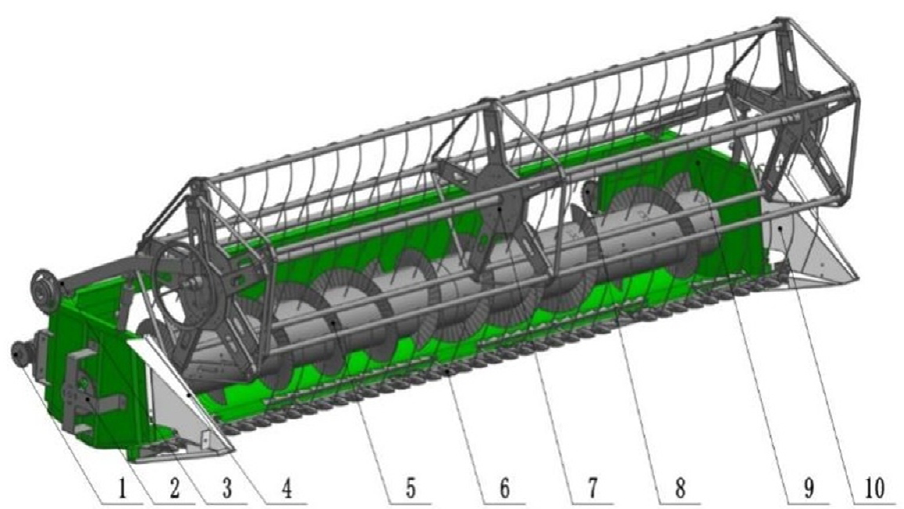
Figure 11. Structure diagram of double-channel header. 1. Gap bridge I; 2. Fixed axis plate; 3. Frame of reel; 4. Left grain dividing device; 5. Two-way spiral conveyor; 6. Cutter; 7. Reel; 8. Gap bridge II; 9. Header floor; 10. Right grain dividing device.